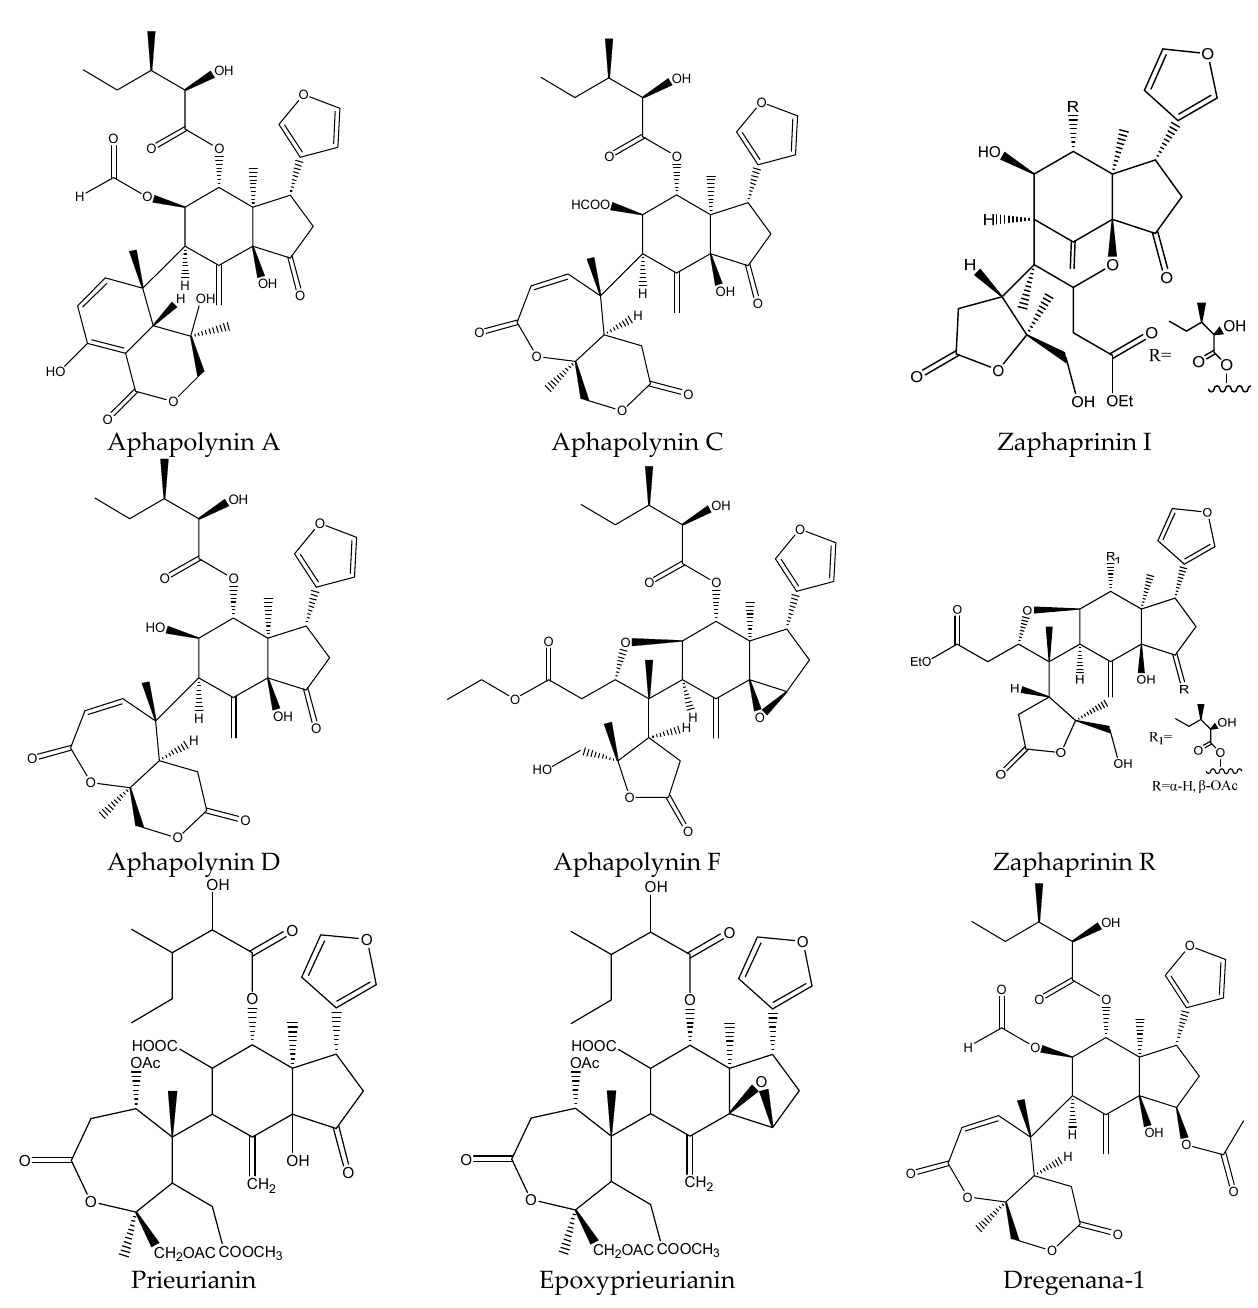
Figure 10. The structures of rings A,B-seco chemicals: prieurianins.